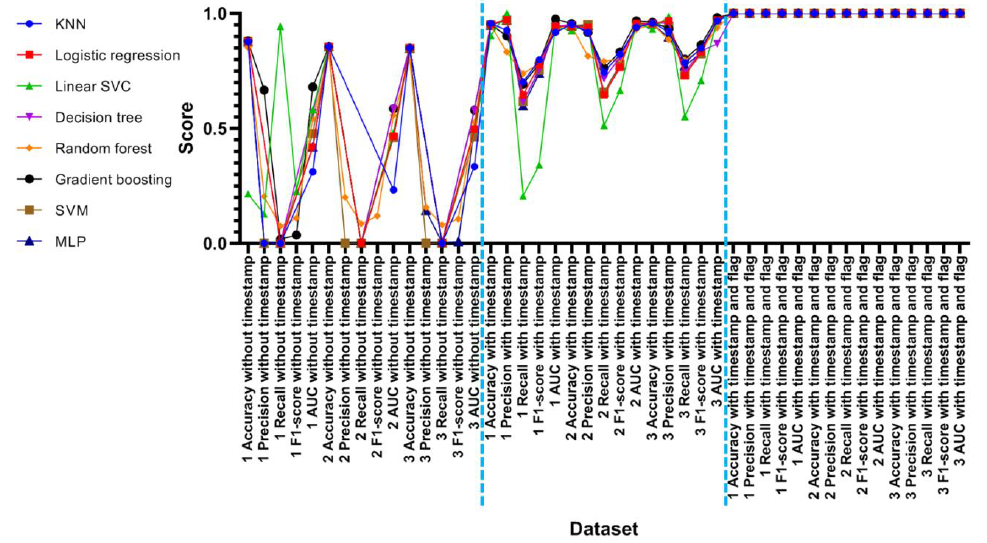
Figure 8. Comparison of performance evaluation according to practical performance evaluation by features.